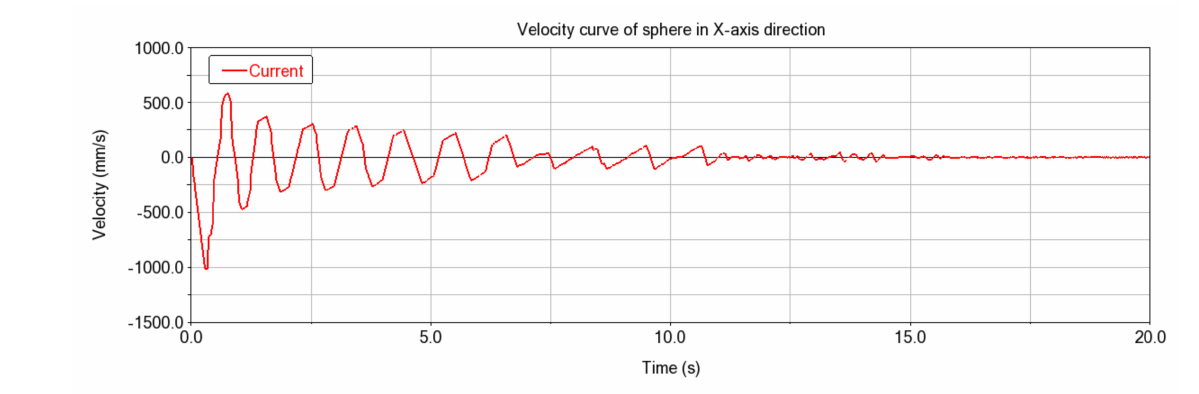
Figure 20. A velocity curve of the sphere in the x-axis